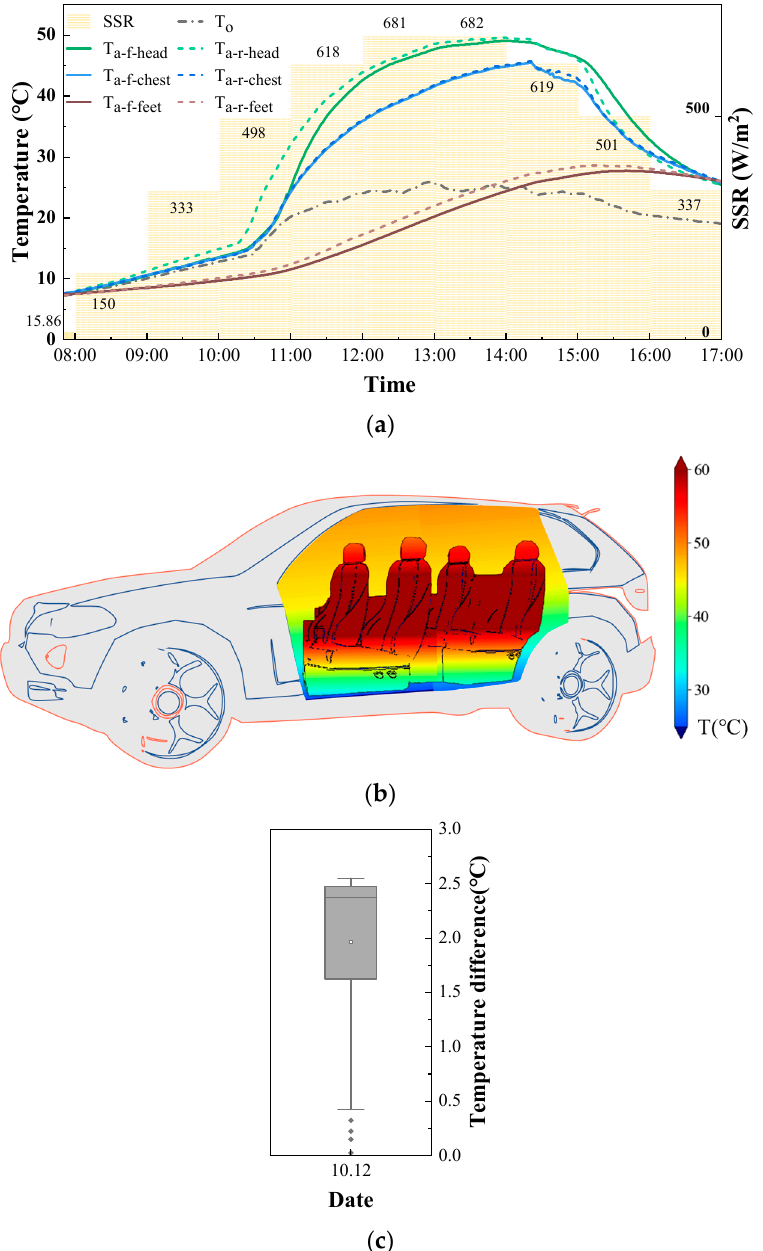
Figure 7. Cabin thermal environment on 12 October: ( a ) variation of the air temperature of vehicle B; ( b ) cabin air and the interior surface temperature distribution of vehicle B at 14:00 and ( c ) air temperature difference between the two vehicles.